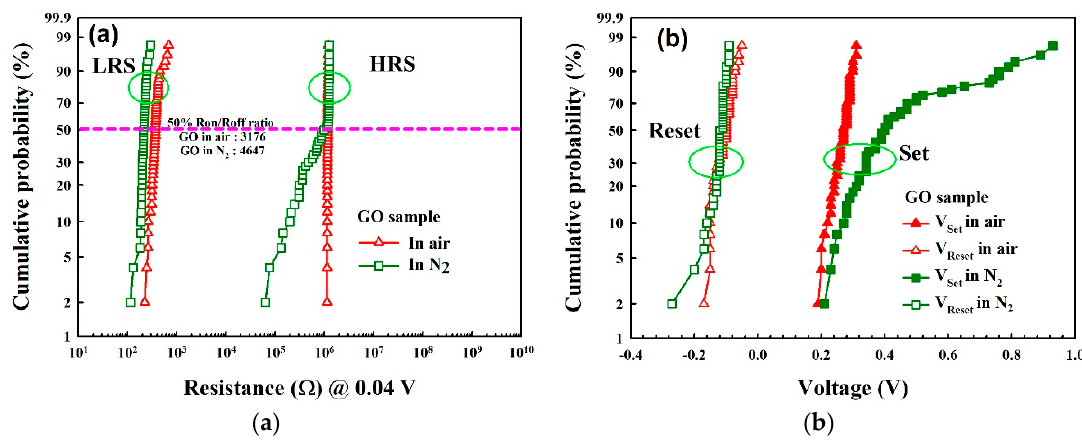
Figure 4. Cumulative probabilities of switching parameters of the GO sample in the atmosphere and the N 2 ambient: ( a ) high-resistance state (HRS) and low-resistance state (LRS) resistances; ( b ) V Set and V Reset